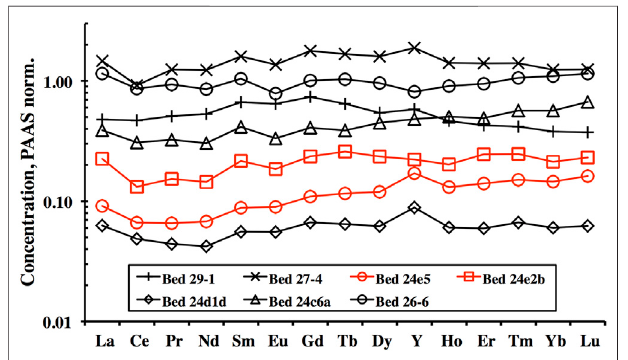
FIGURE 5 | Selected whole rock rare earth element data, normalized to PAAS (Taylor and McLennan, 1985).